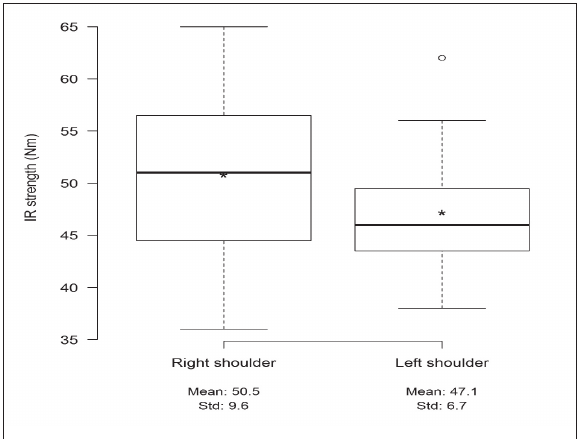
Figure 1 - Comparison between right and left shoulder IR strength in swimmers.